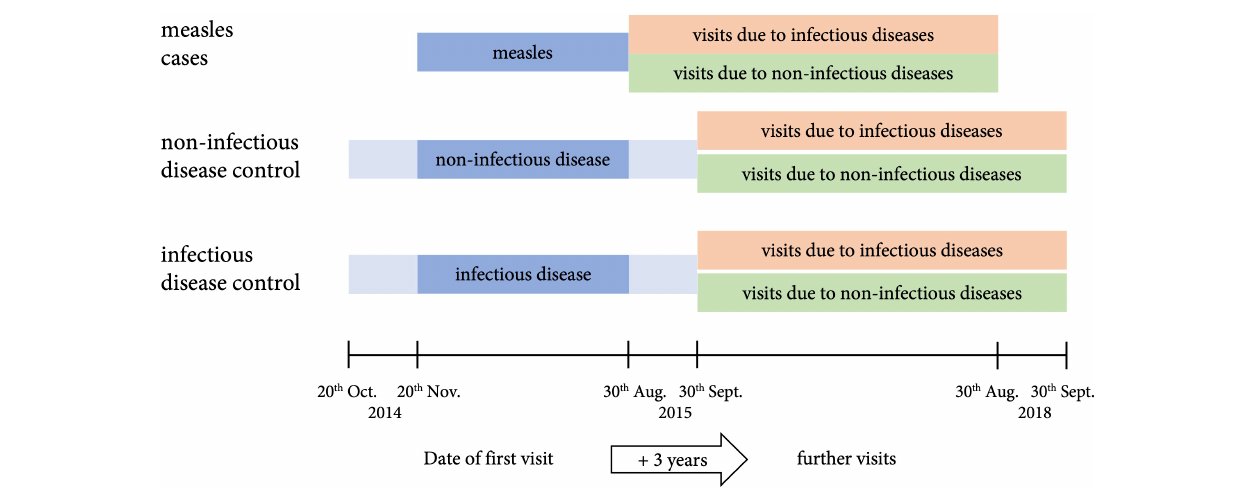
FIGURE 1 | Study design. Children and adolescents (age ≤ 18 years) who fulfilled the WHO case definition for measles and presented to the emergency room during the measles epidemic between 20th October 2014 and 30th August 2015 were included as cases. Controls were matched for sex, age ( ± 10), date of first visit to the hospital ( ± 1 month, illustrated), and duration of in-patient care if applicable ( ± 20% in full days). All patients were followed up for 3